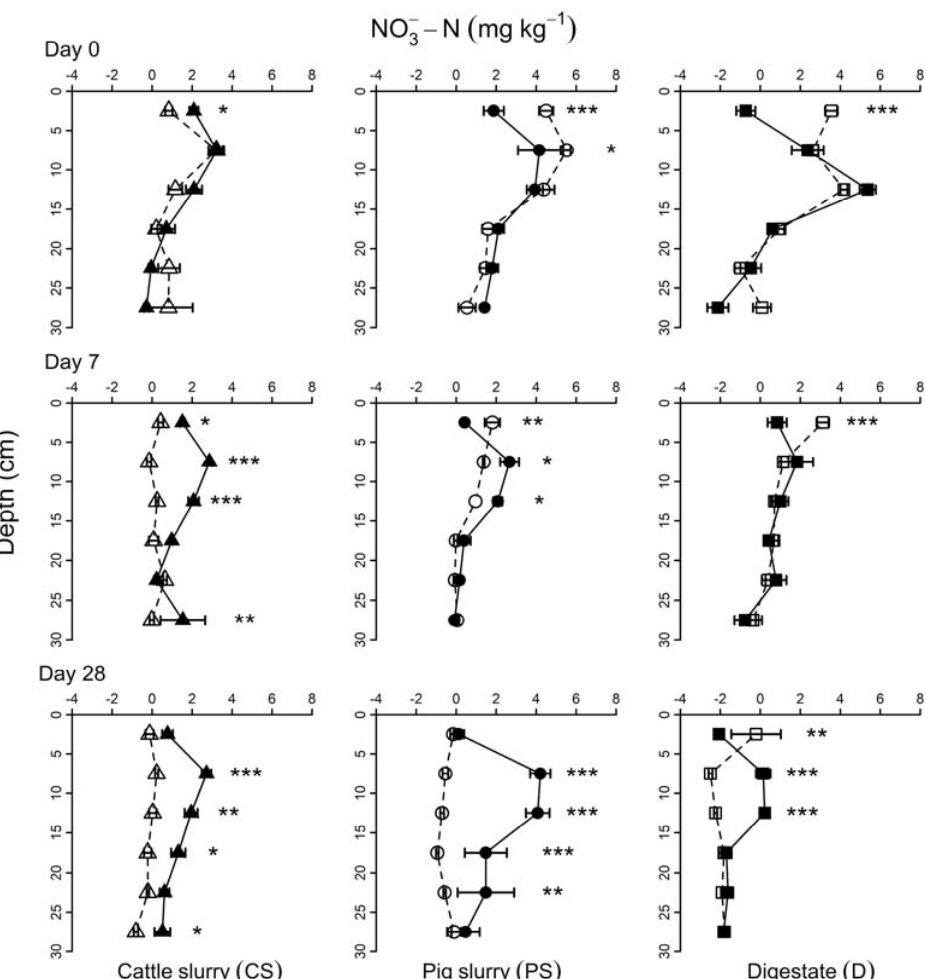
Figure 2. Net nitrate ‐ N (NO 3 − ‐ N) concentration in the soil columns with pig slurry ( ○ ); pig slurry plus N ‐ Lock TM ( ● ); cattle slurry ( ∆ ); cattle slurry plus N ‐ Lock TM ( ▲ ); bio ‐ digestate ( □ ); and digestate plus N ‐ Lock TM ( ■ ). Statistical significance of the differences according to HSD Tukey tests (* P ≤ 0.05; ** P ≤ 0.01; *** P ≤ 0.001).